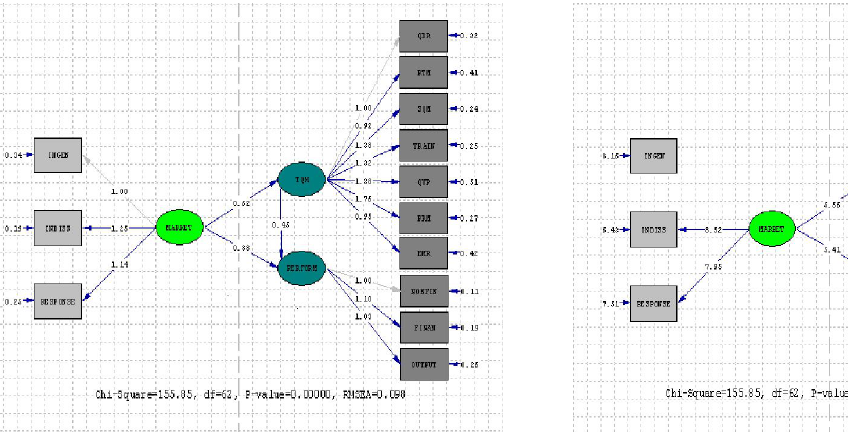
Fig. 2. The results of SEM